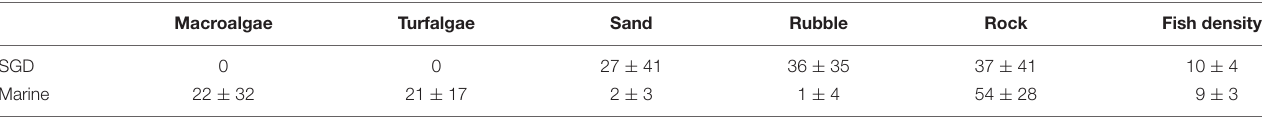
TABLE 2 | Mean benthic cover composition (% ± SD) and juvenile Chrysiptera glauca densities (individuals 100 m − 2 ± SD) in a tide pool affected by fresh submarine groundwater seepage (SGD) and in a strictly marine one (marine). Macroalgae Turfalgae Sand Rubble